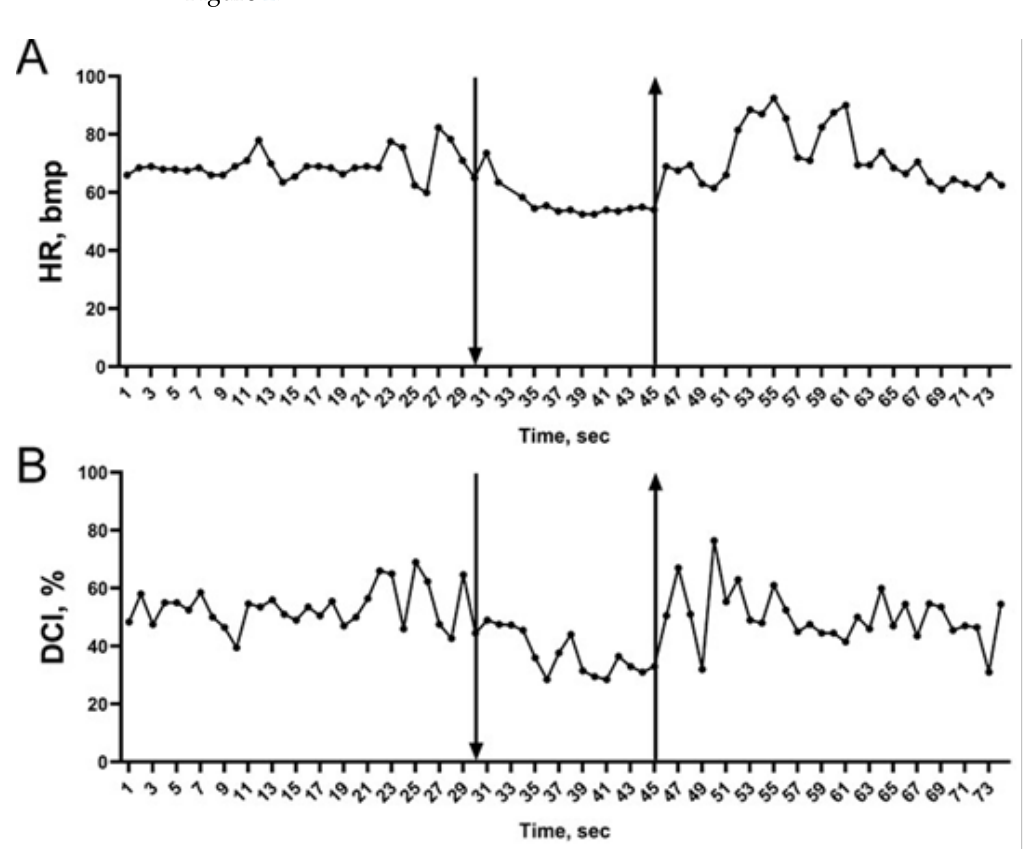
Figure 2. Representative dynamics of cardiac rhythm and pulmonary vascular dicrotic index changes in the subject M during imitation of the diving reflex. Arrow pointing down indicates the beginning of face submersion; arrow pointing up indicates the end of face submersion. ( A ) Changes in heart rate (HR) during imitation of the diving reflex. ( B ) Changes in dicrotic index (DCI) during imitation of the diving reflex.